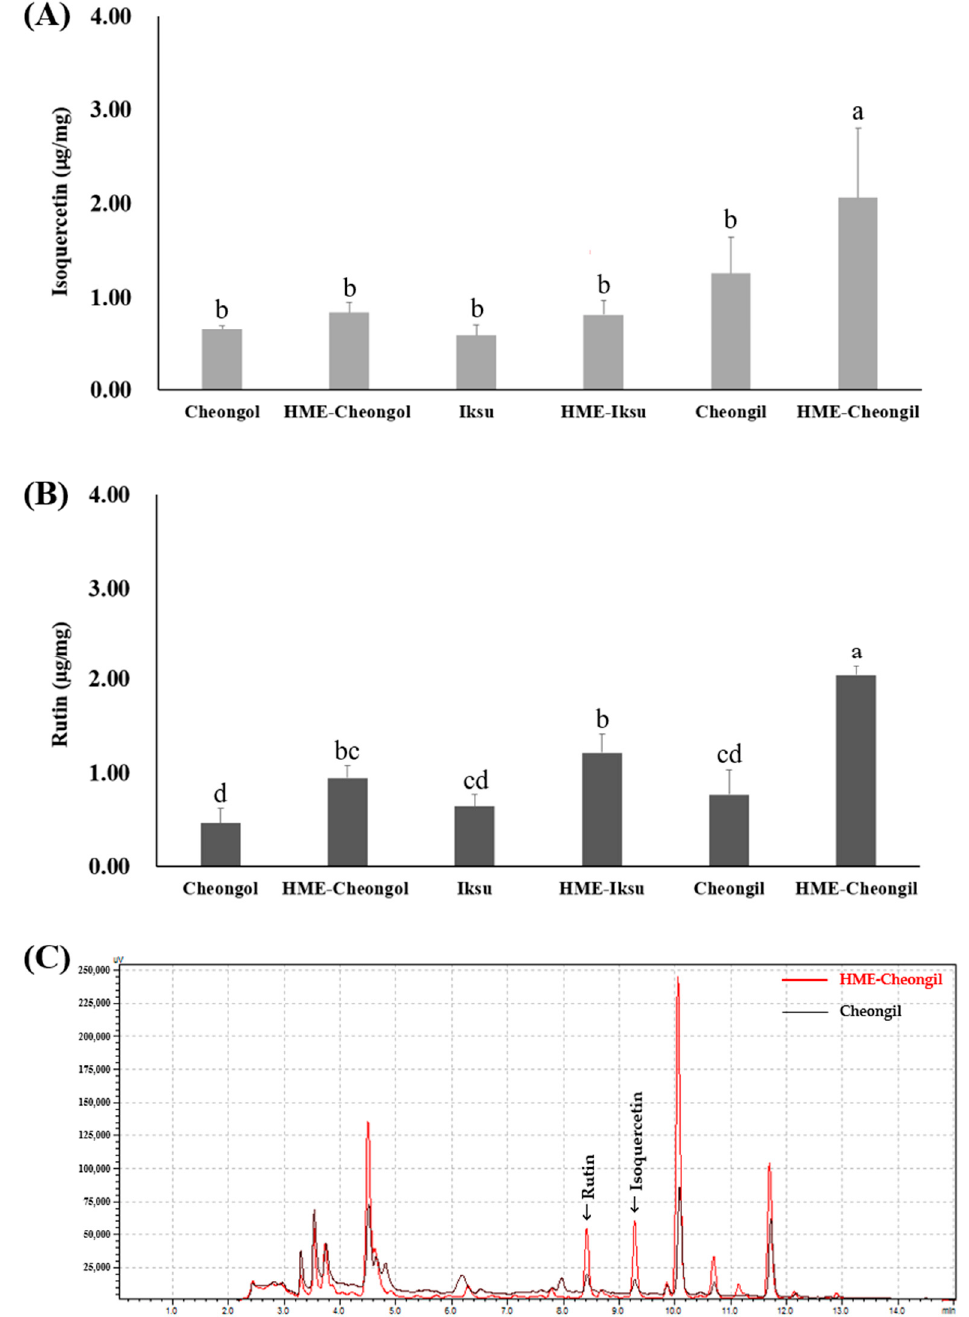
Figure 1. ( A ) Isoquercetin and ( B ) rutin contents of mulberry leaf and HME-ML extract; and ( C ) HPLC chromatogram of rutin and isoquercetin in Cheongil and HME-Cheongil extract. Data are expressed as mean ± standard deviation ( n = 3). Means with different letters vary significantly with Duncan’s Multiple Range Test (DMRT) at 5% level ( p < 0.05) within samples.